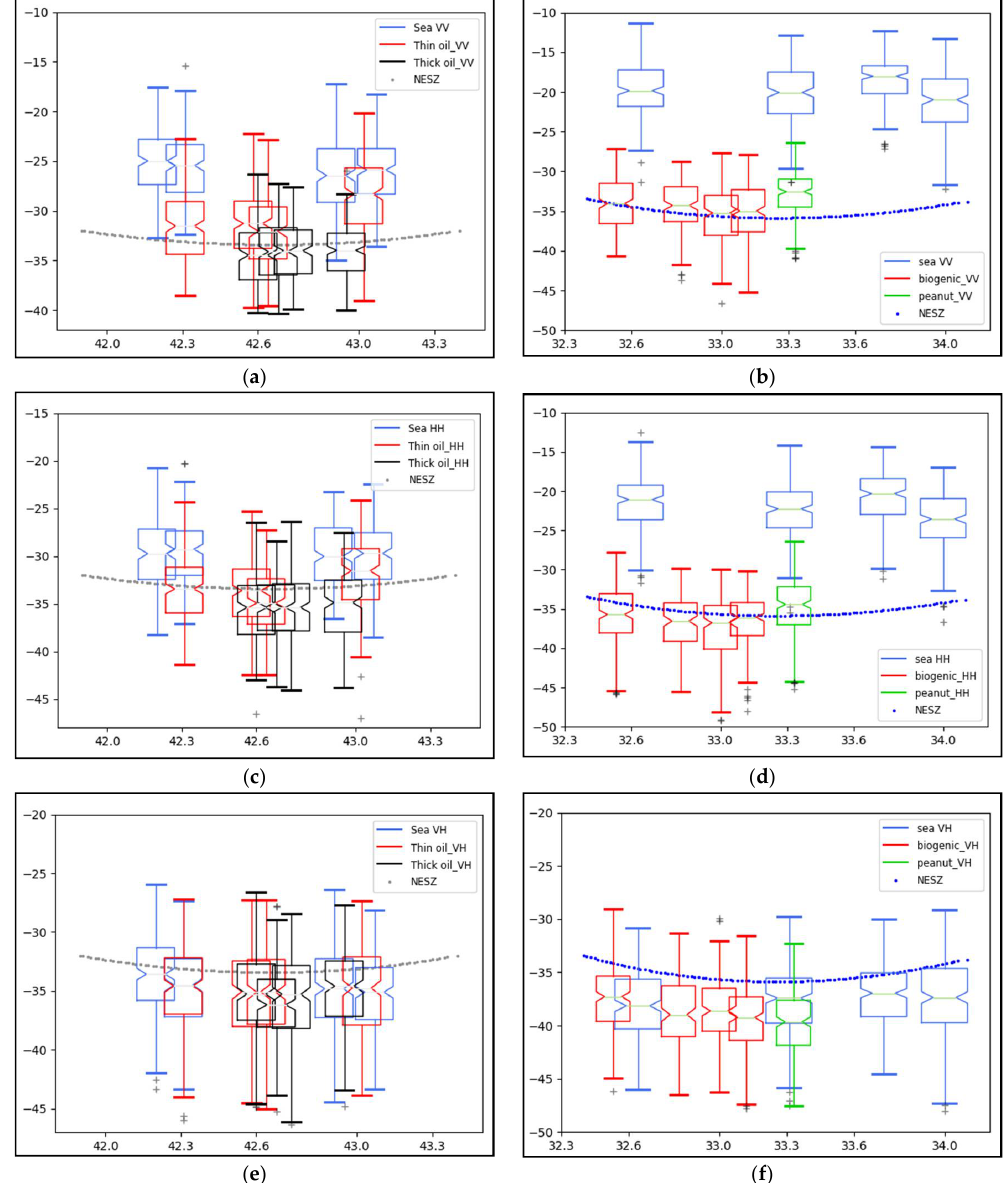
Figure 4. Signal-to-noise analyses: ( a ) VV channel (Case 1); ( b ) VV channel (Case 2); ( c ) HH channel (Case 1); ( d ) HH channel (Case 2); ( e ) VH channel (Case 1); ( f ) VH channel (Case 2). Each box represents the backscatter signal range in the regions indicated by the colored boxes in Figures 2 and 3.